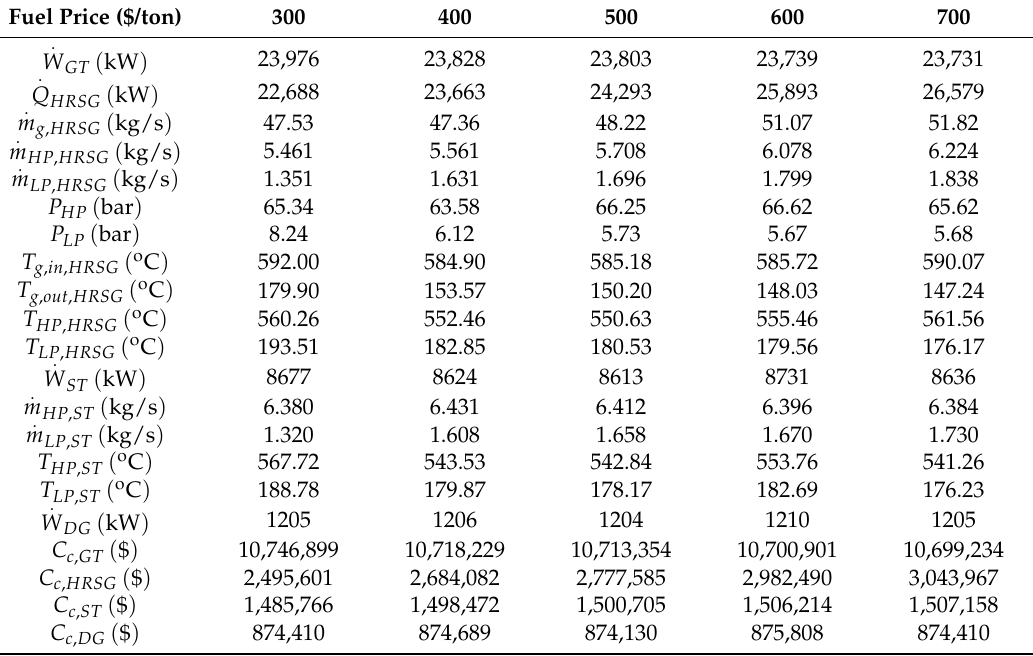
Table 14. Optimal design characteristics and capital cost of the system components for various MDO